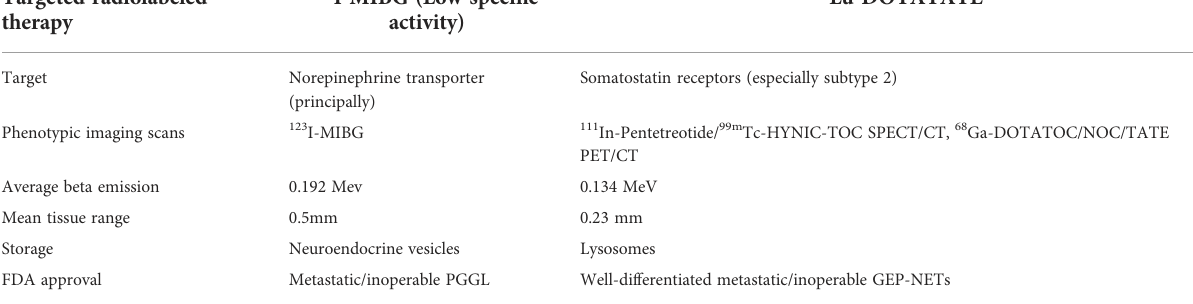
TABLE 1 TRT modality